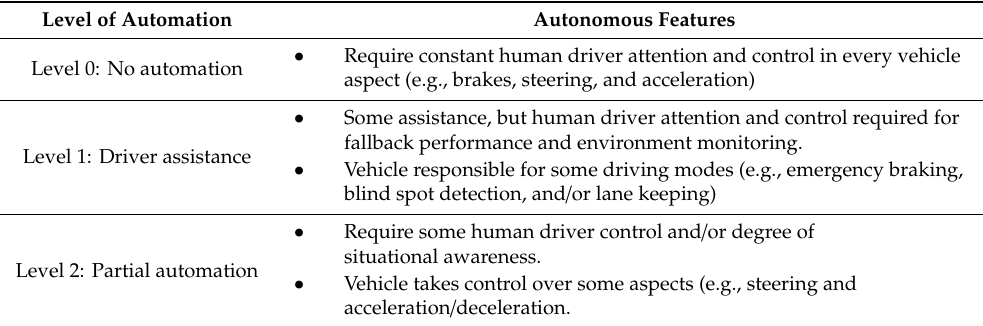
Table 1. Vehicle levels of automation and